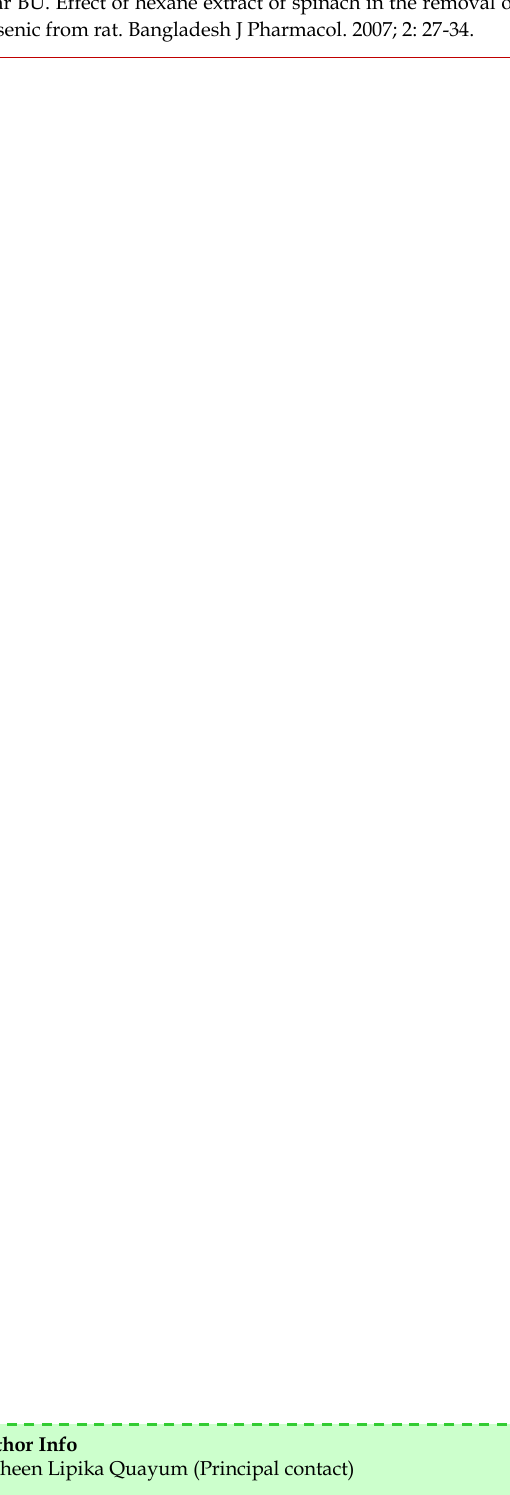
Tabassum NE. Effect of (cid:450) - lipoic acid on the removal of arsenic from arsenic-loaded isolated liver tissues of rat. Bangladesh J Pharmacol. 2006; 1: 27-32. Umar BU. Effect of hexane extract of spinach in the removal of arsenic from rat. Bangladesh J Pharmacol. 2007; 2: